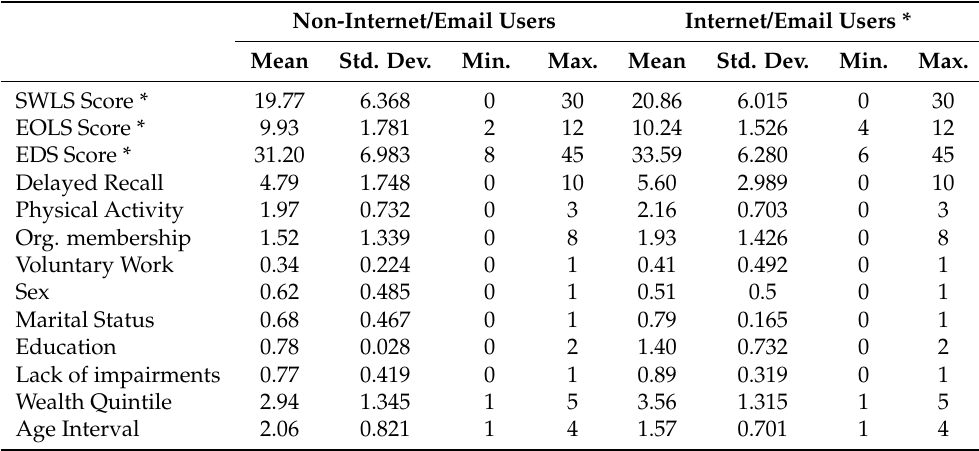
Table 2. Baseline characteristics of the analytical sample measured at Wave 3 by Internet/Email use. English Longitudinal Study of Aging 2006–2007. Main descriptive